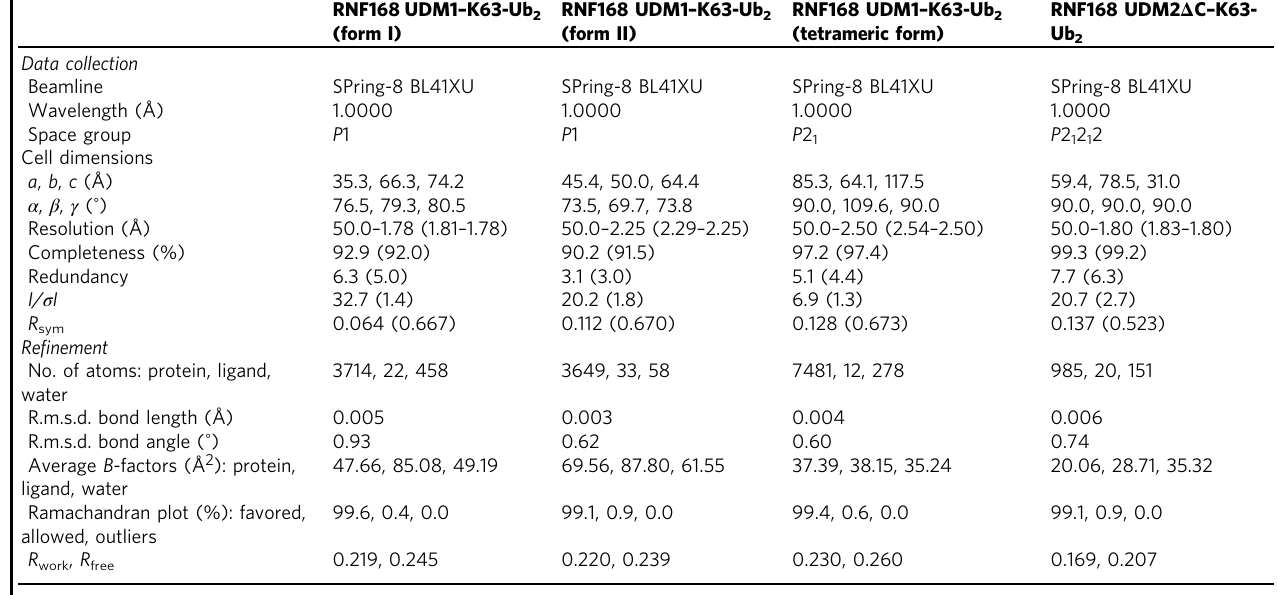
Table 2 Data collection and re fi nement